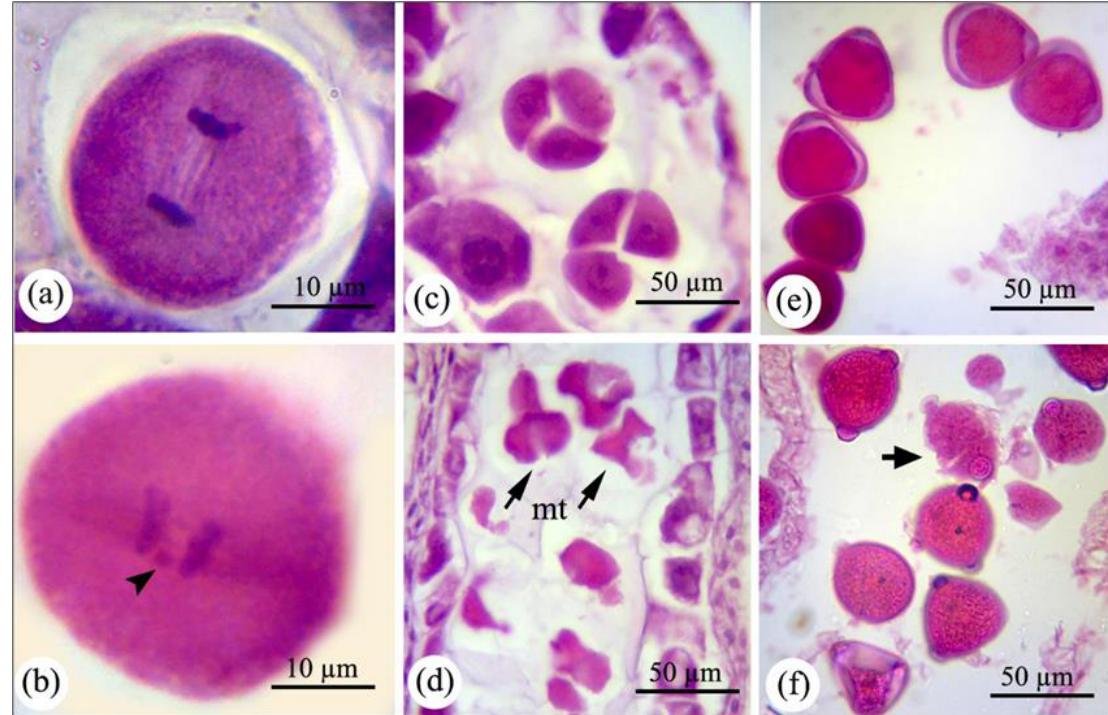
Figure 1. The microsporogenesis process occurred in control and 2000 mg L −1 nCeO 2 -treated plants. ( a ) Pollen mother cell at anaphase I in control plants ( b ) pollen mother cell at anaphase I, which chromosomes separation has not been appropriately accomplished and led to generating the laggard chromosome (arrowhead). ( c ) Pollen mother cell at the tetrad stage in control plants. ( d ) Abnormal and degenerated tetrads (arrows) in nCeO 2 -treated plants. ( e ) Mature pollen grains in control and treated plants. ( f ) Degenerated (arrow), and misshaped pollens are visible in anthers of plants exposed to higher dosages of nCeO 2 . mt, microspore tetrad.